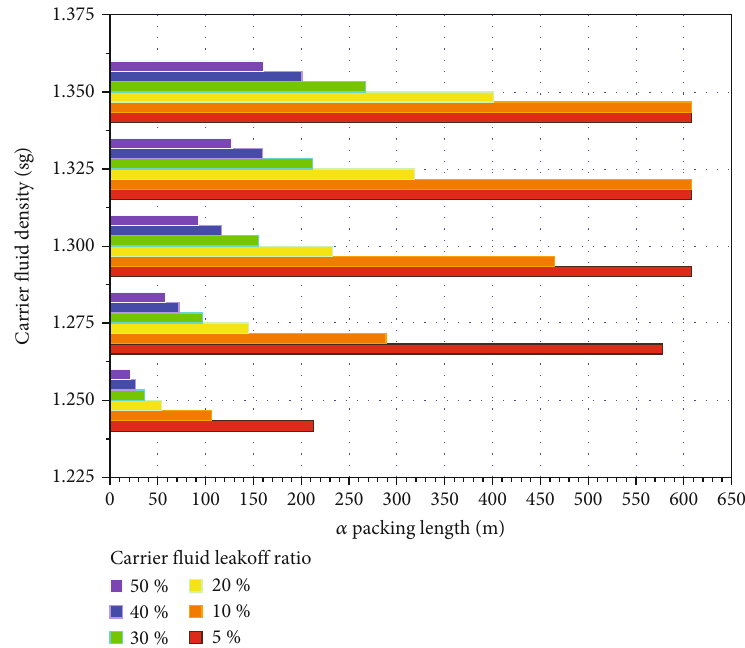
Figure 4: In fl uence of density and leako ff of carrier fl uid on α packing length.